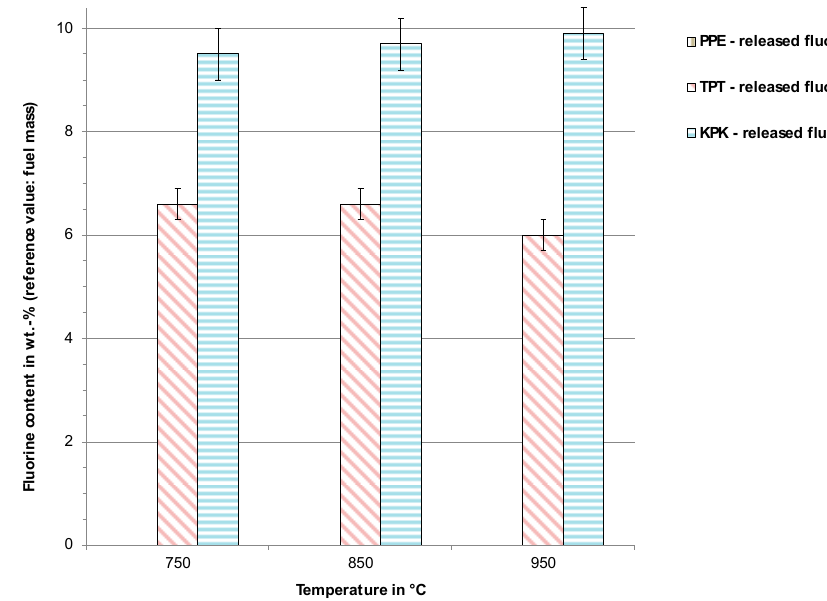
Figure 7. Incineration results of fluorine transfer into the gas phase from PPE, TPT, and KPK.